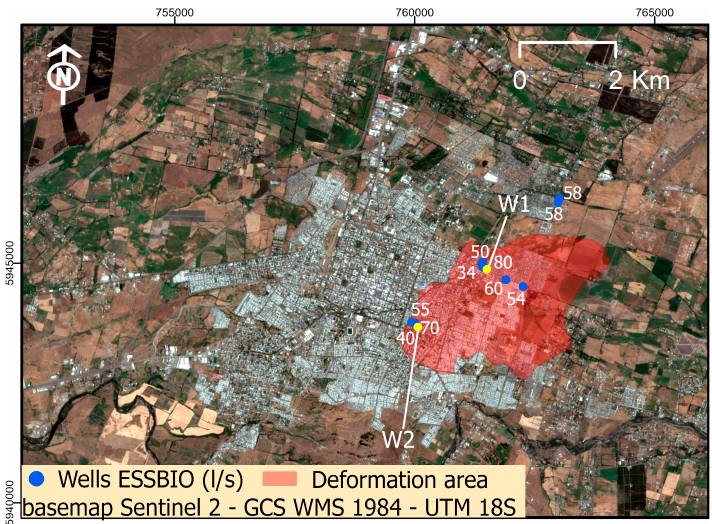
Figure 11. Deformation area and location wells of Sanitary Services Company (ESSBIO), background image Sentinel 2 ESA (2022), yellow dots Well 1 (W1) and Well 2 (W2).